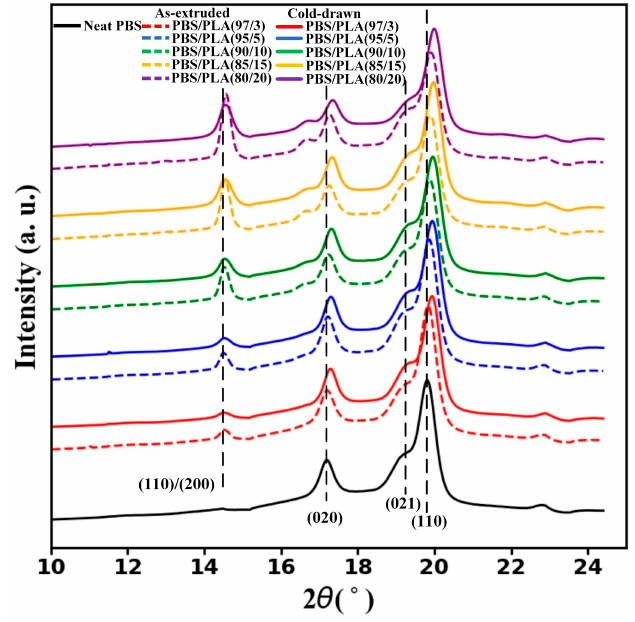
Figure 9. 1D-WAXD diffraction profiles of neat PBS and PBS/PLA composites.